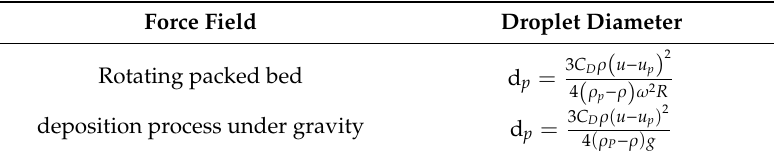
Table 4. Droplet diameter under di ff erent force